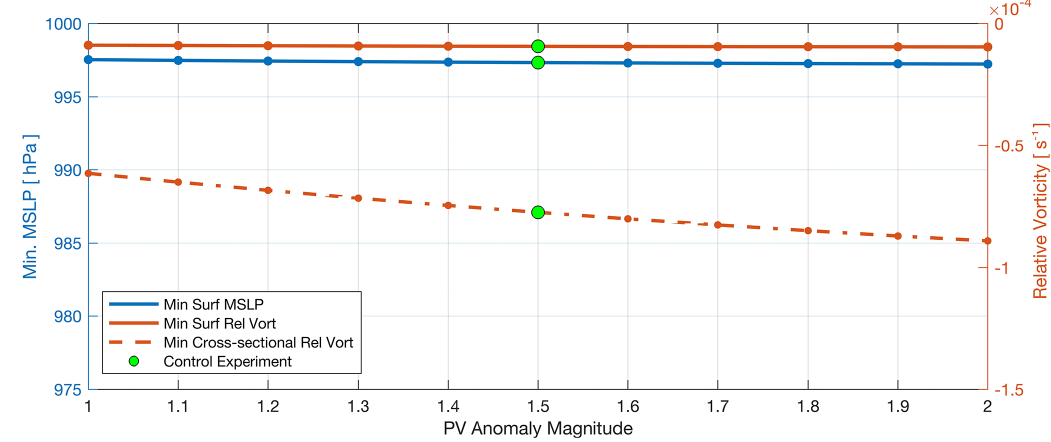
Figure 13. Same as in Fig. 8 but for Experiment 4 (varying stratospheric intrusion magnitude experiments).